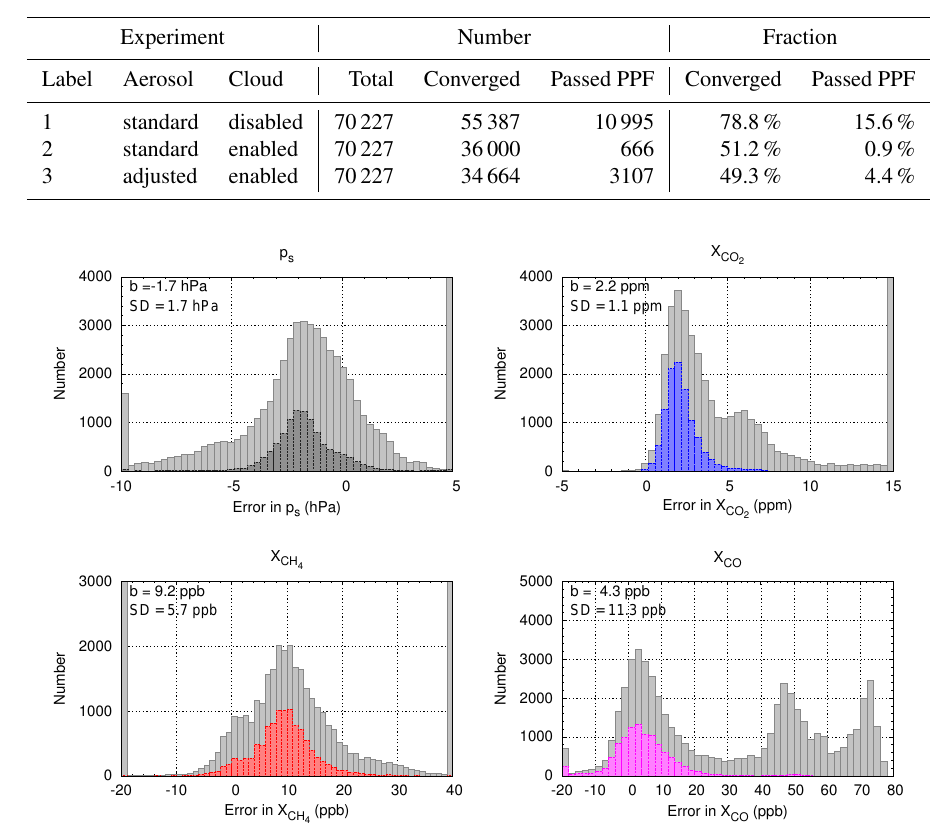
Figure 7. Histograms of errors in retrieved surface pressure p s , X CO aerosol. The PPF has been applied to the coloured histograms, but not to those in light grey. The biases (b) and standard deviations (SD) quoted are for the histograms after the PPF. Of the total of 55387 cases that converged, 10995 passed the PPF